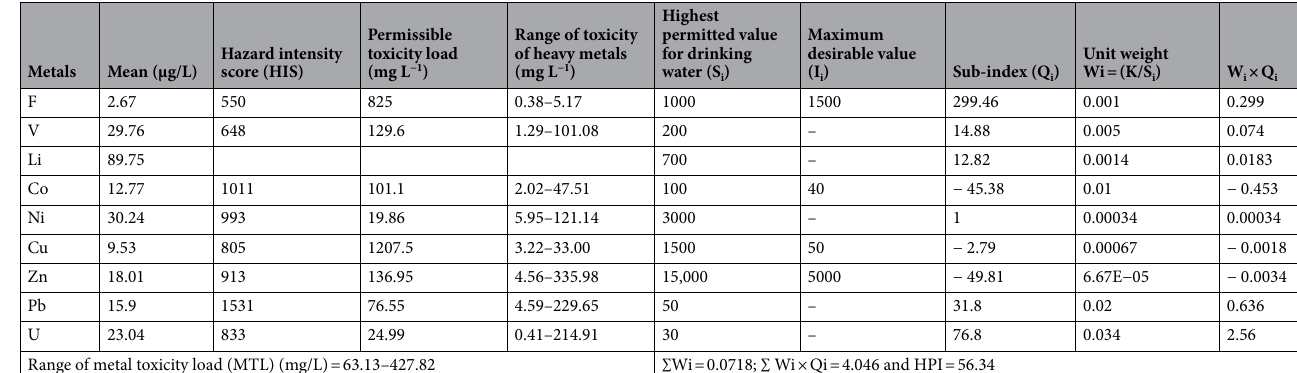
Table 3. Metal toxicity load of the groundwater following ATSDR (2017) relative to the toxicity level of metals accountable for human beings and computation of heavy metal pollution index (HPI) for groundwater of western Rajasthan and Northern